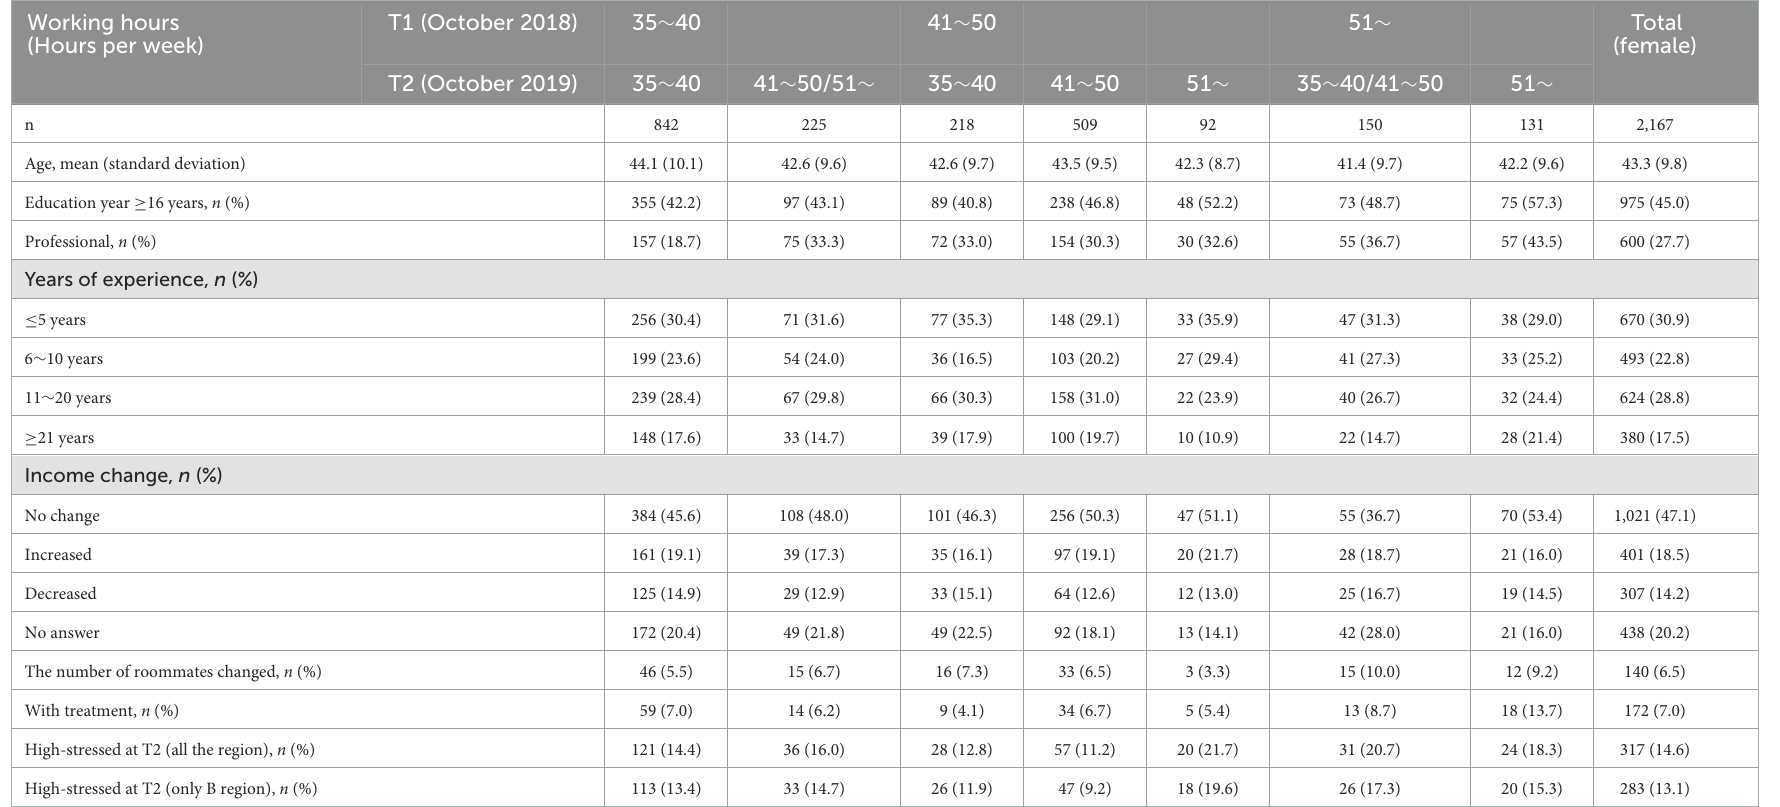
TABLE 1 Summary of backgrounds and characteristics of female